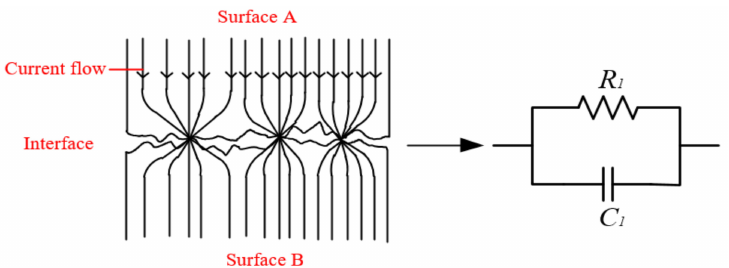
Figure 2. Equivalent connection impedance network of a contact surface between connector pin and receptacle.